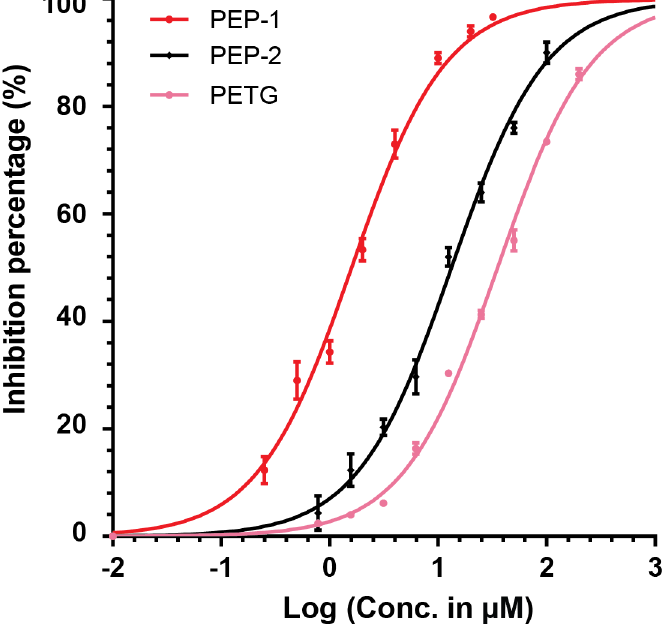
Fig 1. Selected lead peptides of PEP-1 and PEP-2 for inhibiting β -Gal. The IC 50 of peptideinhibitionis measuredat a substrate concentration of 100 μ M RBG (resorufin β -D-galactopyranoside) and β -Gal concentration of 150 μ g/L, 25˚C. PETG is a known competitiveinhibitorof β -Gal. All tests includedthree replicates. Error bar: range of